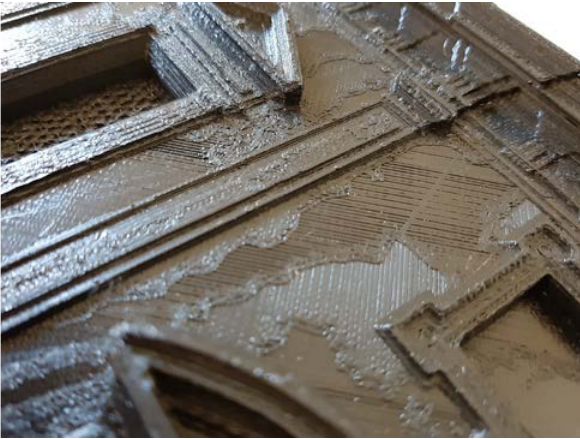
Figure 11. Detail of the deterioration of the facade The surface finish of the masonry parts at a resolution of 6-10 mm in reading with a laser scanner and printing at the layer height of 0.10 mm is fine. As said by visually disabled